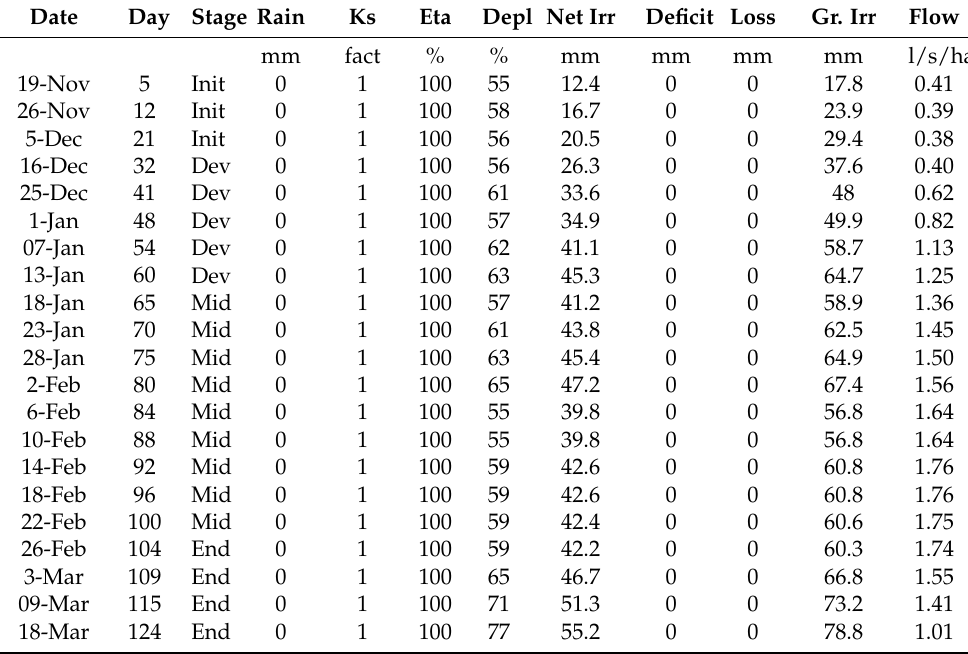
Table 7. Irrigation schedule for